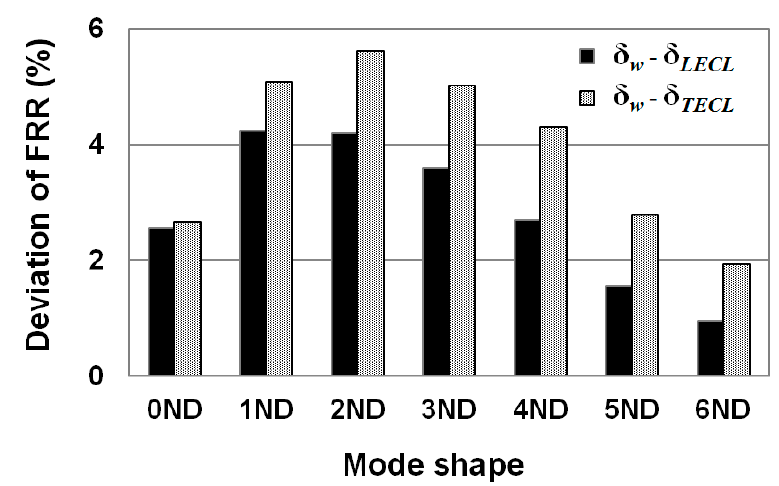
Figure 17. Comparison of the deviation of FRRs for the runner.